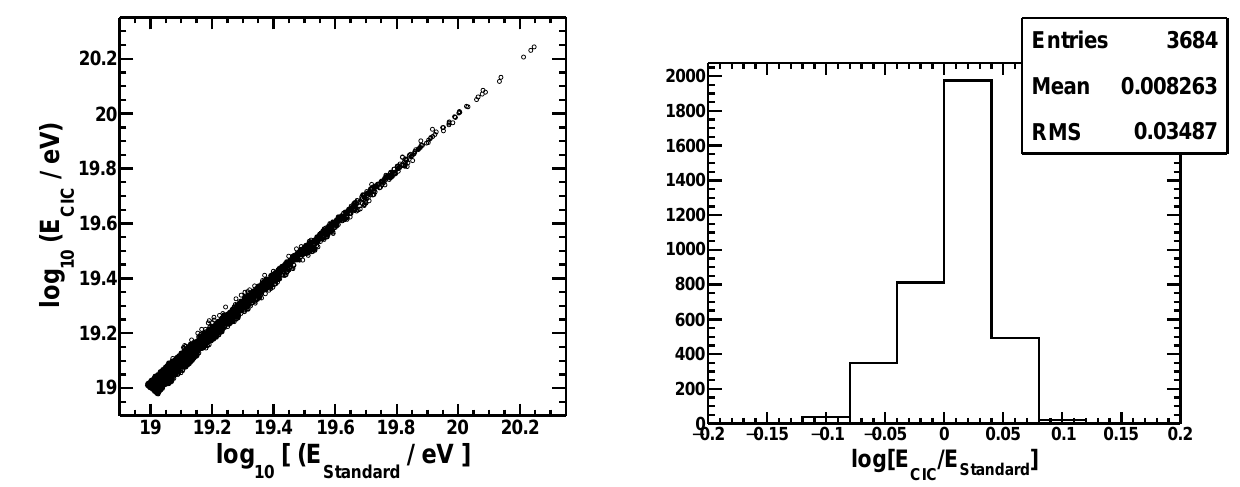
Figure 7. Event by event comparison of the TA SD standard and CIC reconstruction methods. Left panel shows the scatter plot and the right panel shows the ratio of the energies calculated by the standard and CIC methods.